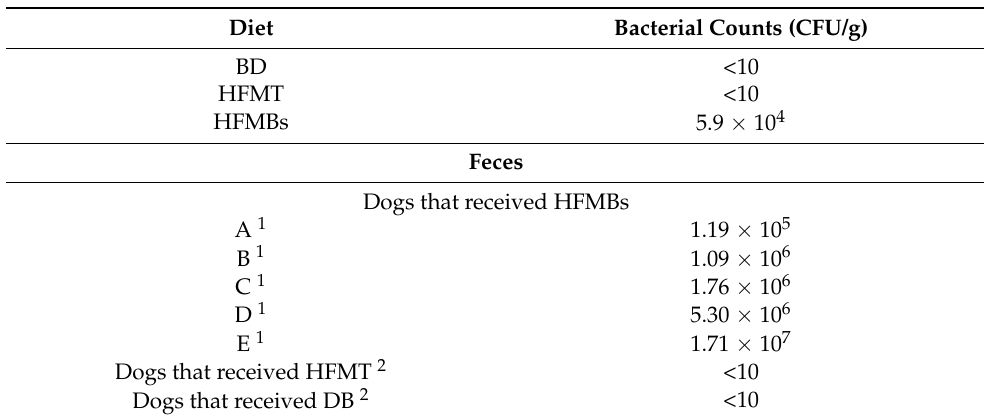
Table 4. Colony forming units (CFU/g) in the basal diet (BD), diets containing 9.09% ( w / w ) feather meal hydrolyzed by Bacillus subtilis (HFMBs), 9.09% ( w / w ) thermal hydrolyzed feather meal (HFMT) and feces that consumed the diets.